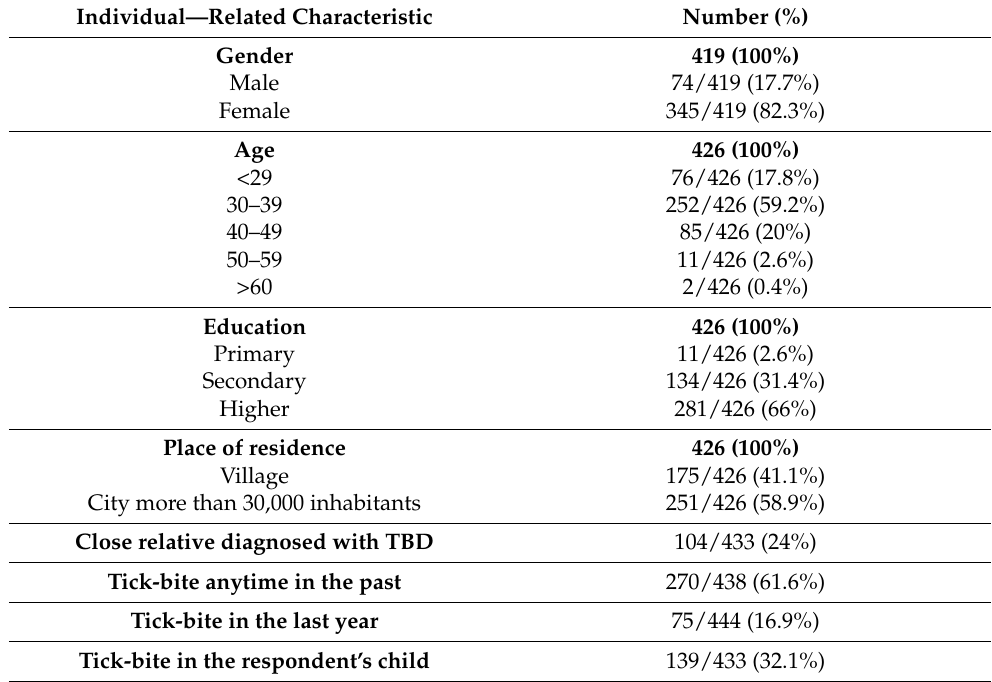
Table 1. Characteristics of surveyed parents of children hospitalized in the Department of Pediatric Infectious Diseases in